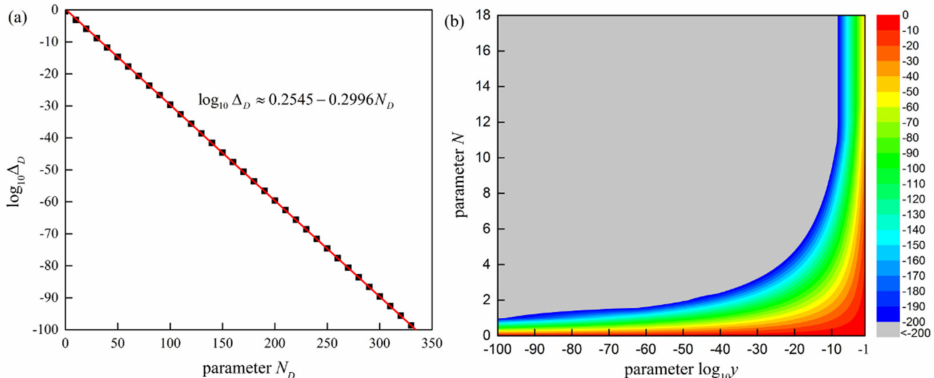
Figure 2. ( a ) The maximum relative error ∆ D of Dawson’s integral calculated by Equation (15) in the domain 0 ≤ x < 22 under different N D and ( b ) the maximum relative error ∆ w of Voigt/complex error function calculated by Equation (27) in the domain | x + i y | < 22 and 10 − 100 ≤ y ≤ 0.1 under different N and y with the error caused by the Dawson’s integral is ignored ( N D =